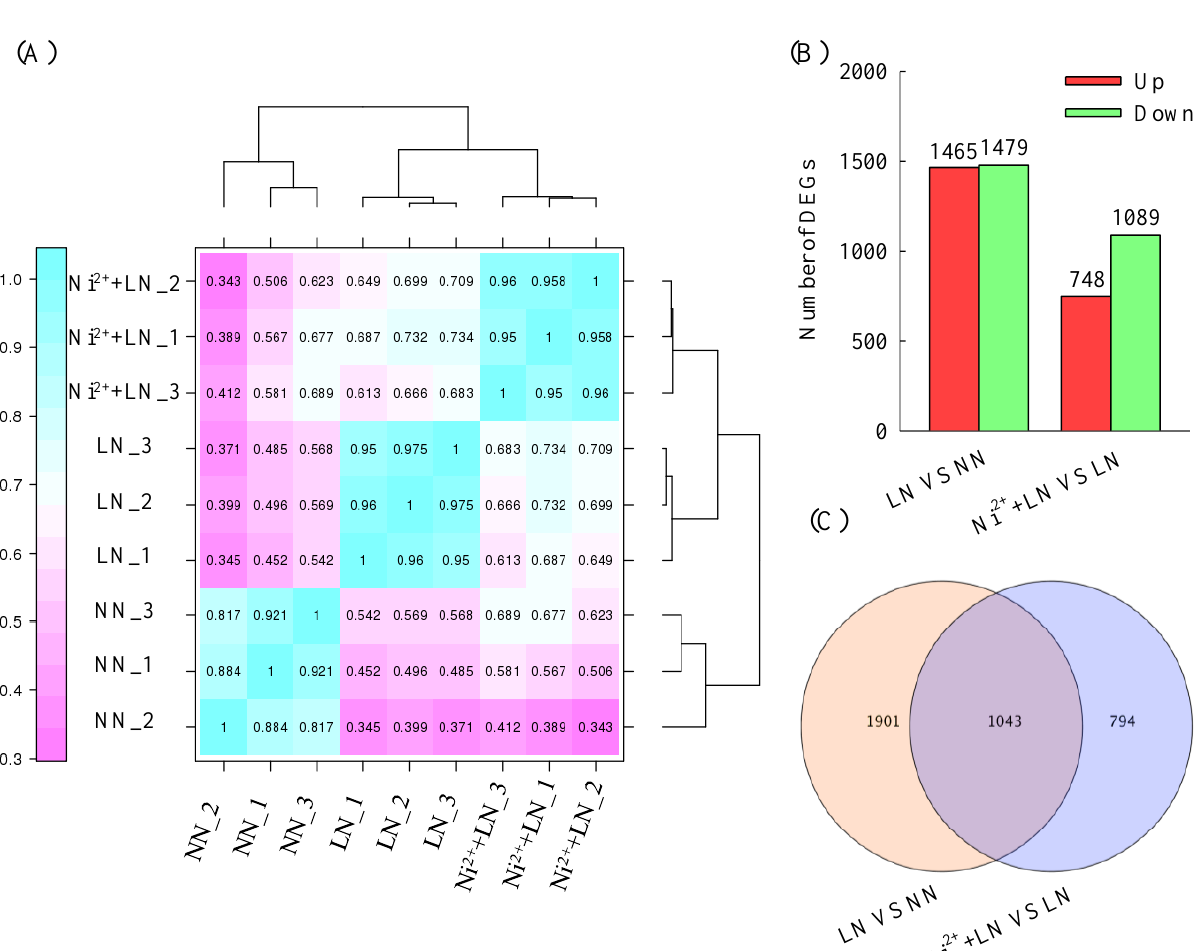
Figure 4. Statistics of the transcriptome in the tomato roots. Pearson’s correlation analysis ( A ), number of DEGs ( B ), and Venndiagram ( C ).